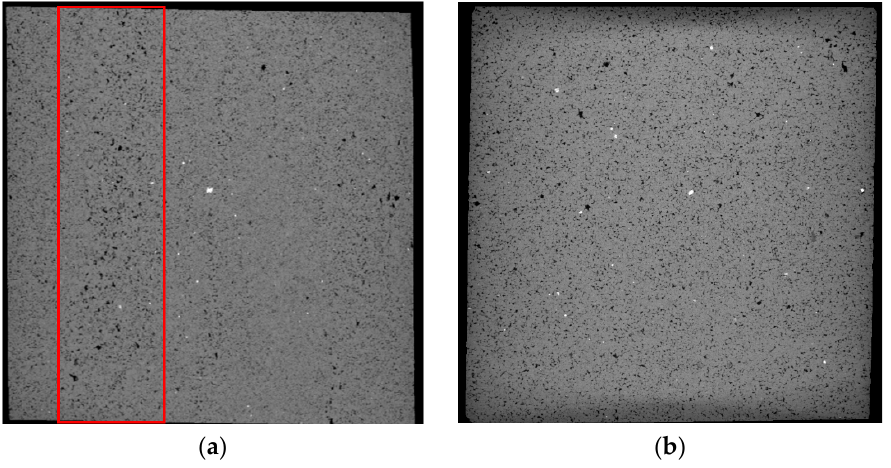
Figure 10. CT scan of samples 2 ( a ) and 3 ( b ). Density shown in gray gradient. The zone with increased porosity is marked with a red rectangle. Voids shown in black, matrix in grayscale.